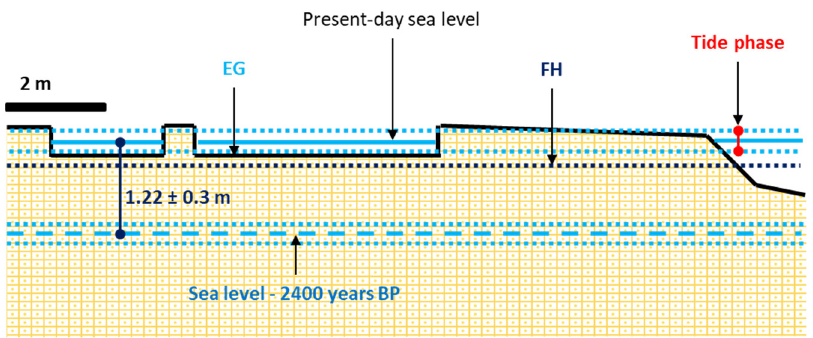
Figure 7. Sea-level assessment in 2400 years BP compared to the current sea-level measured in the coastal quarries of Mola di Bari; EG = elevation of a geoarchaeological marker, FH = functional height.